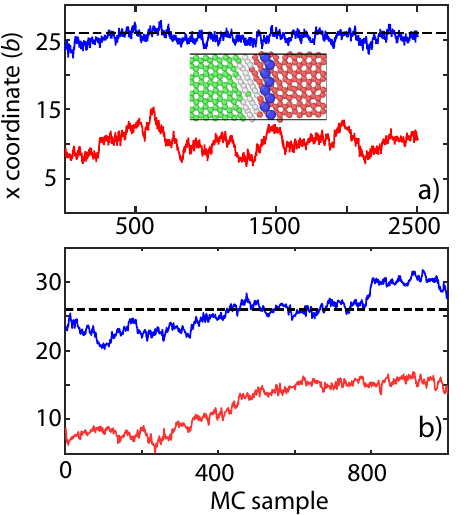
Fig. 3 Partial-dislocation centroids positions with impurities for T = 0.267 K and T = 1.067 K. a Atomistic centroid dislocation positions in the presence of 2 rows of 3 He impurities at T = 0.267 K. Horizontal dashed line indicates center position of the two impurity rows. Insets display centroid snapshots of two atomic planes, above and below the glide plane respectively. Meaning of red, green and white colors is the same as in Fig. 1. Blue spheres depict centroids of 3 He impurities. b ) Same as in a ), but at T = 1.067